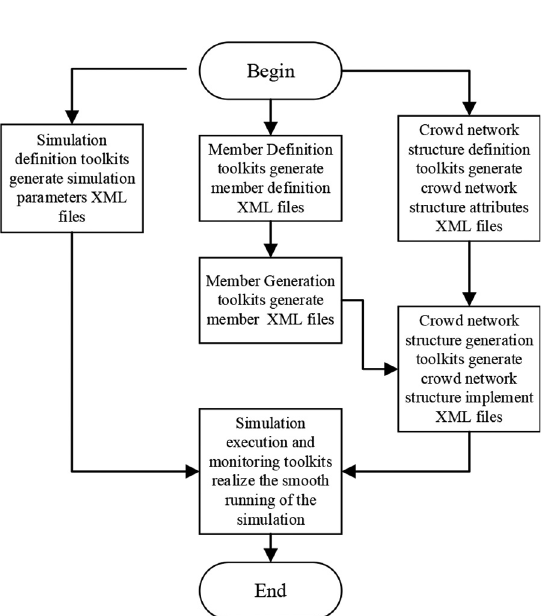
Figure 16. Simulation result